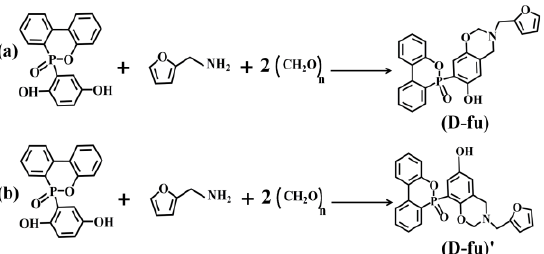
Figure 1. The possible chemical-reaction pathways of furfurylamine type benzoxazine monomer of ( a ) and ( b ).